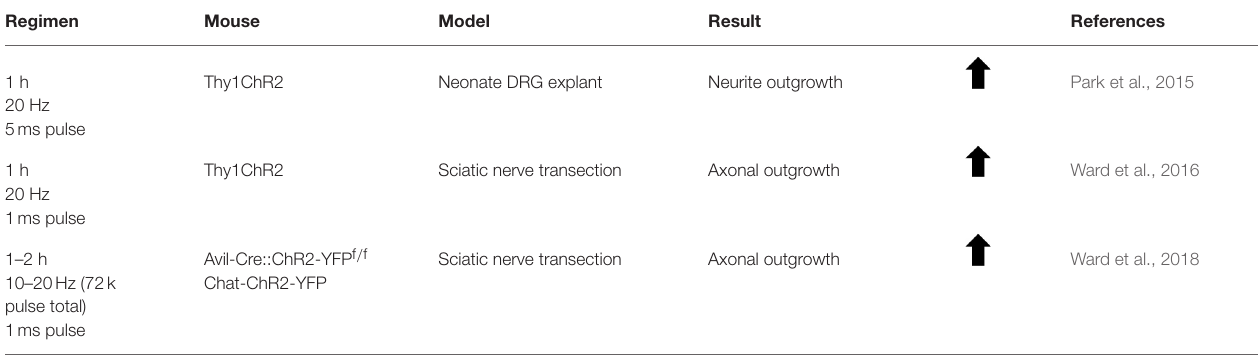
TABLE 5 | Effect of optogenetic stimulation on peripheral nerve regeneration.